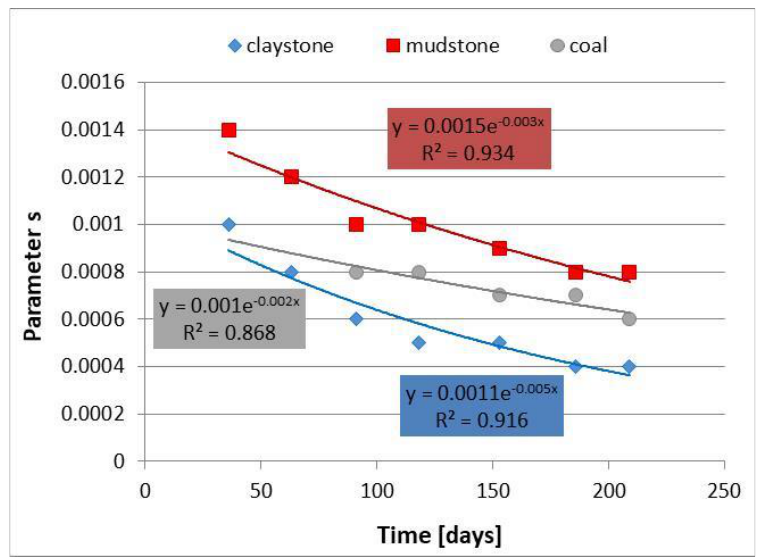
Figure 18. Changes in the post-failure parameter s of the rocks around roadway F-33 — convergence- monitoring station at chainage 405 m.